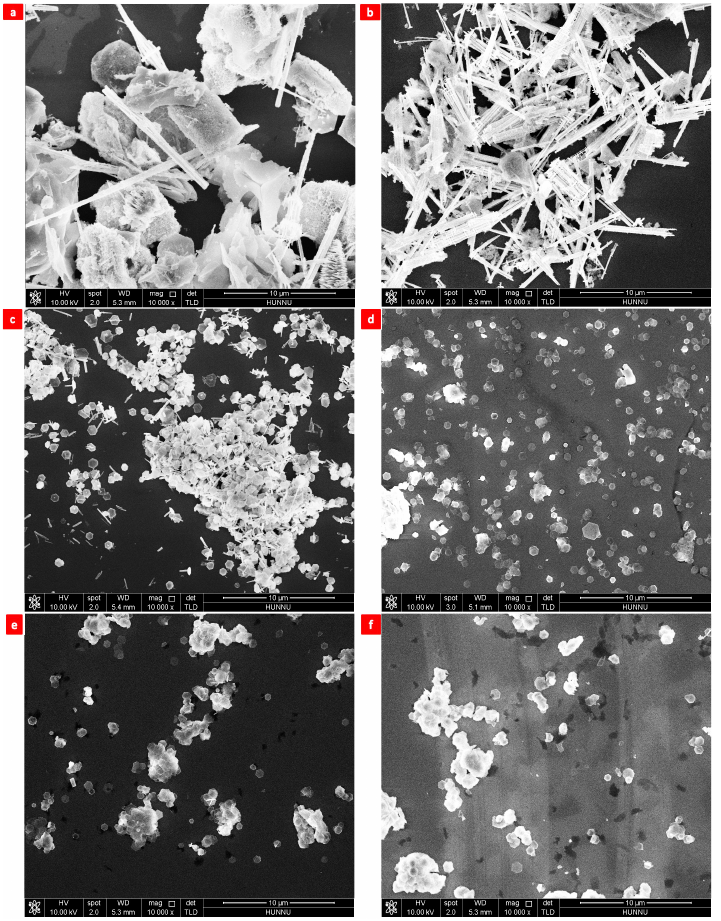
Figure 4. A series of the weight of NaOH ( a ) 0 g, ( b ) 0.2 g, ( c ) 0.4 g, ( d ) 0.8 g, ( e ) 1.6 g, ( f ) KOH. Table 2. A series of the weight of NaOH influenced on the morpholoy of Bi 2 Te 3